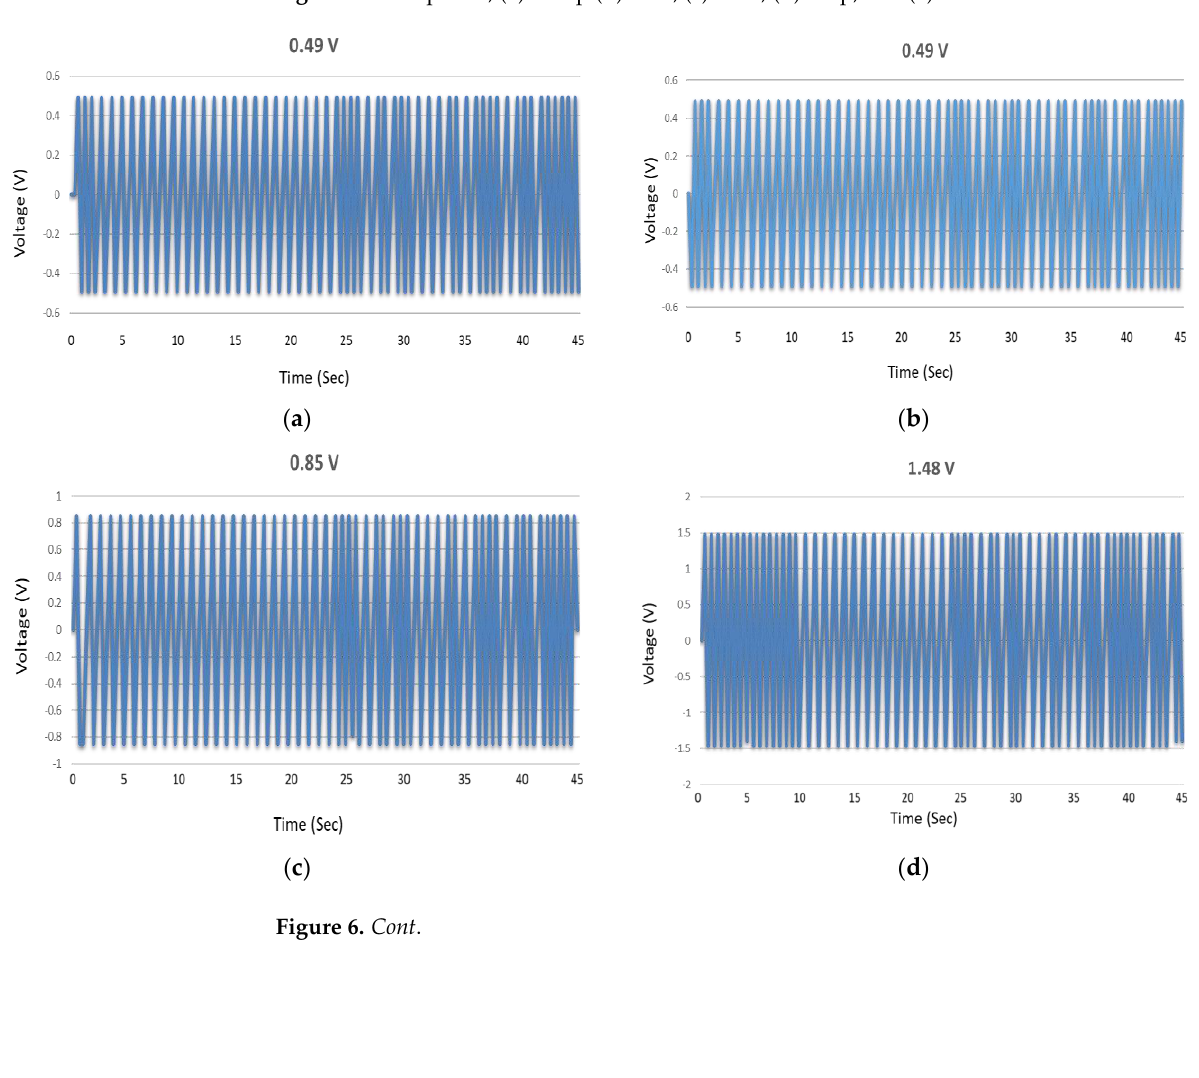
Figure 5. XPS spectra, ( a ) Zn 2p ( b ) O 1s, ( c ) Li 1s, ( d ) K 2p, and ( e ) Na 1s.